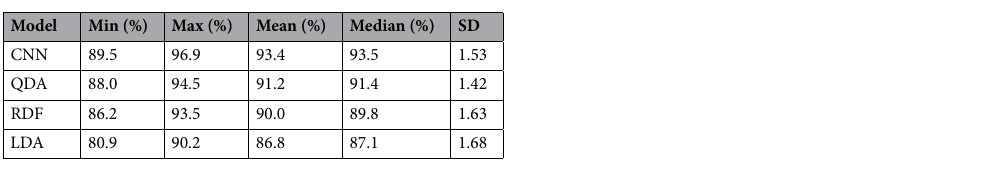
Table 2. The results of the individual analysis